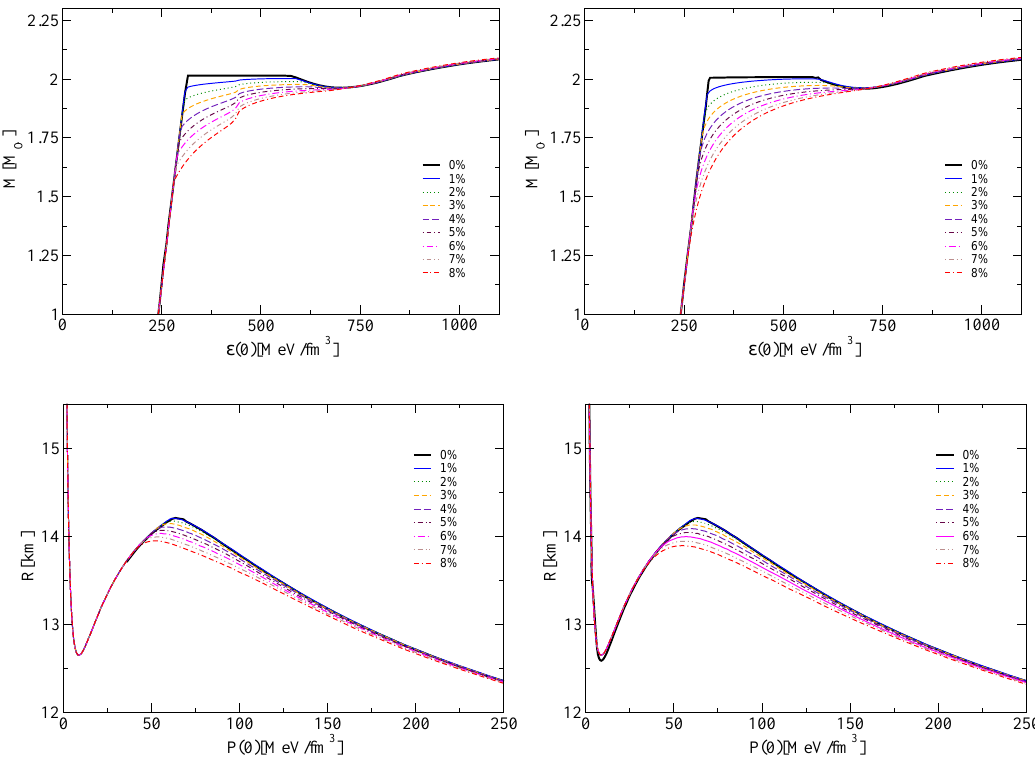
Figure 8. Upper panel : Mass as a function of central energy density for both mixed phase approaches, MIM ( left panel ) and RIM (right panel ). Lower panel : Radius as a function of central pressure for all MIM ( left panel ) and RIM ( right panel , k = 3) sequences. Each curve corresponds to an EoS with a chosen ∆ P value given as a percentage of the critical Maxwell pressure P c represented by alternating line-styles. The case ∆ P = 0 corresponds to the Maxwell construction which produces a sharp edge in the